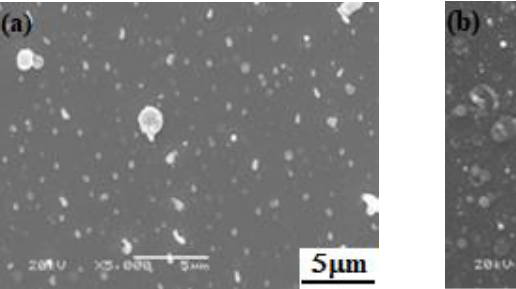
Figure 1. SEM images of In 2 O 3 samples annealed at ( a ) 400 °C, ( b ) 600 °C, and ( c ) 800 °C, respectively, for 2 h.